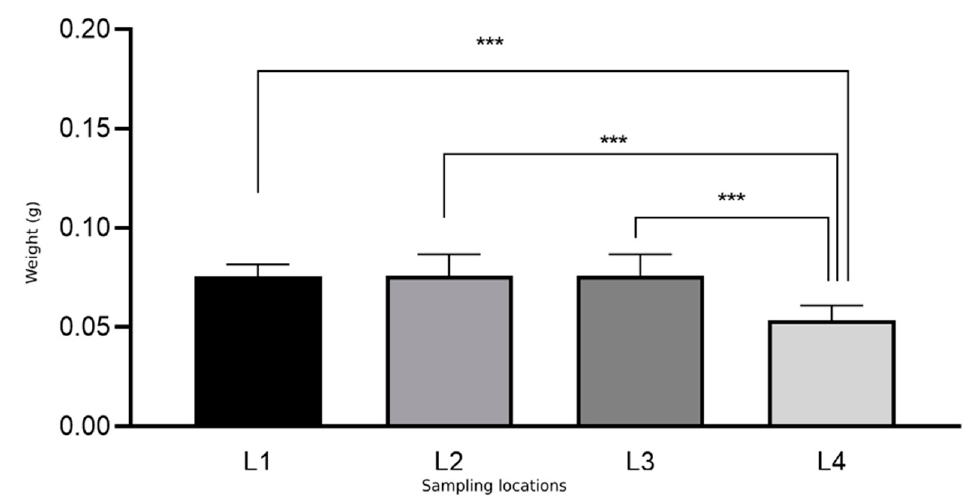
Figure 4. Weight means values of the emerged adult Osmia bicornis at different locations. Asterisks indicates statistically significant differences: L1, L2, L3 vs. L4, *** p < 0.0001; mean ± SD. The weight means values of the emerged adult O. cornuta were highest at L2 (0.128 ± 0.028 g) and decreased as follows: >L4 (0.112 ± 0.028 g), >L1 (0.110 ± 0.029 g) and >L3 (0.070 ± 0.028) (Figure 5). Significant differences were observed between bees’ weight between L2 and L1, L2, L4; between L3 and L1, L2, L4; and between L4 and L3 (F = 168.7; p < 0.0001).